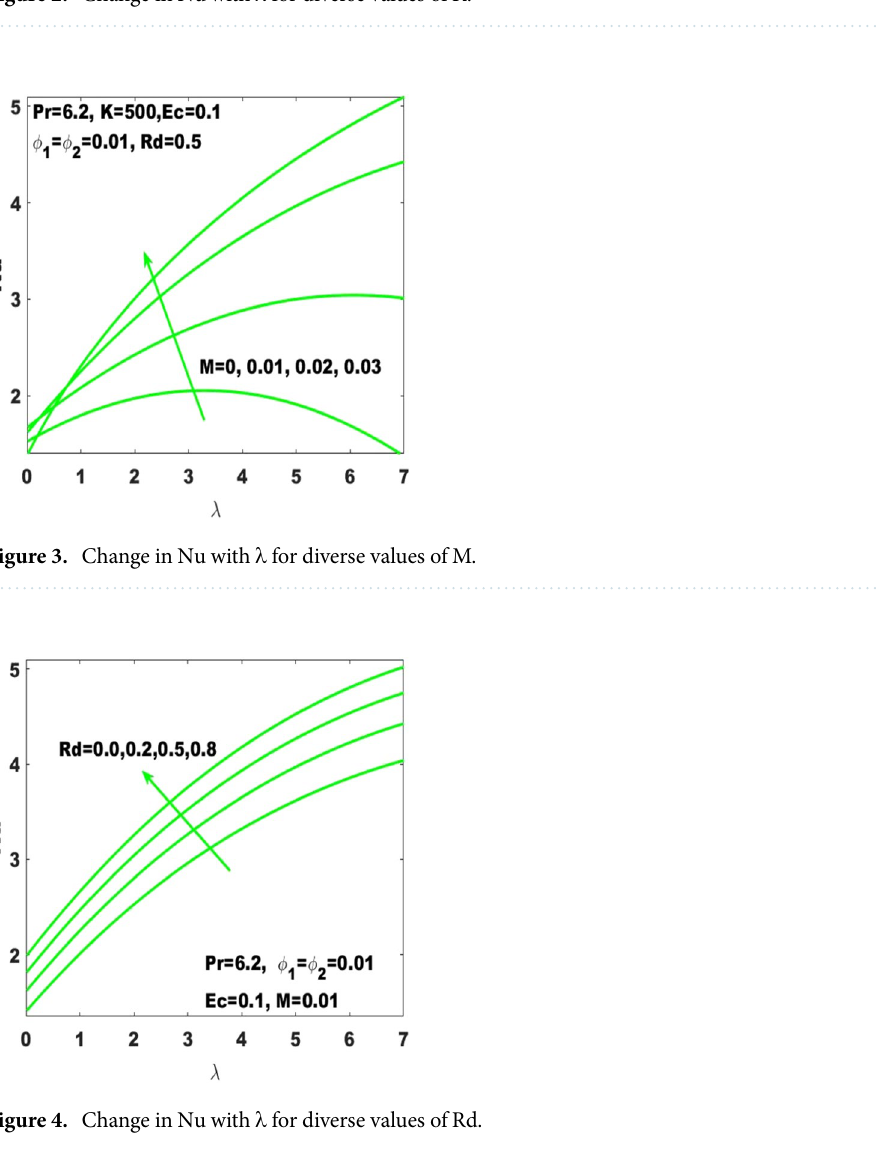
Figure 2. Change in Nu with (cid:31) for diverse values of K .